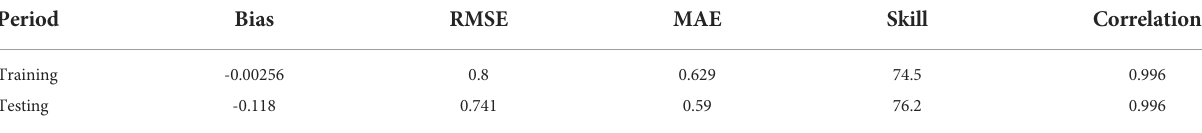
TABLE 2 Skill of the SST model hindcast during the training (1986 – 1998) and testing (1999 – 2016) periods.